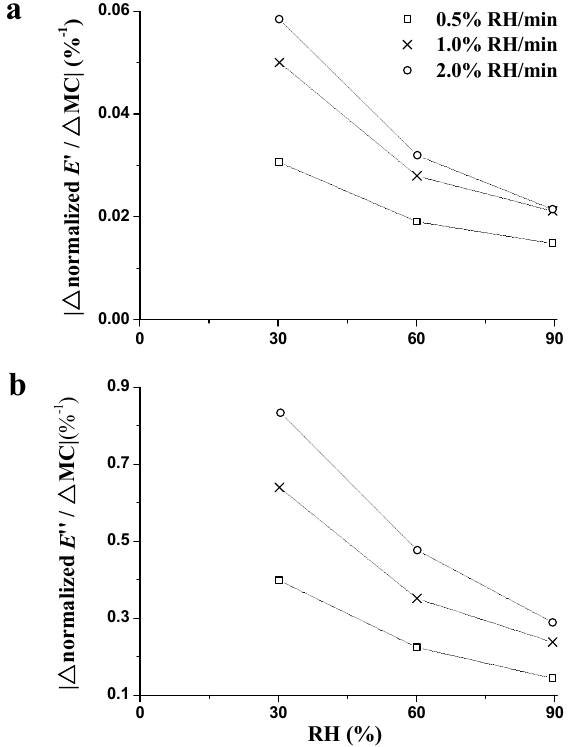
Figure 6. Influence of RH on the absolute changes of normalized E ′ ( a ) and normalized E ″ ( b ) per unit change in MC with different RH ramping rates.